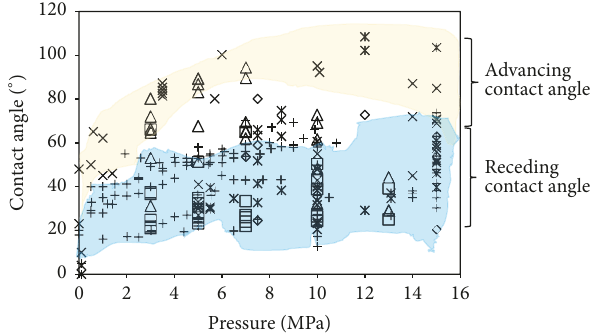
Figure 7: Initial and final contact angles in this study and all com- piled data in previous studies such as advancing/receding/equilib- rium contact angles on mica surface. Hollow rectangle and triangle markers are initial and final contact angles in this study, respectively. Plus (+), cross ( × ), and diamond ( ⬦ ) markers are receding, advanc- ing, and static (or equilibrium) contact angles measured in previous studies, respectively [9, 10, 14, 21, 23, 24, 34,